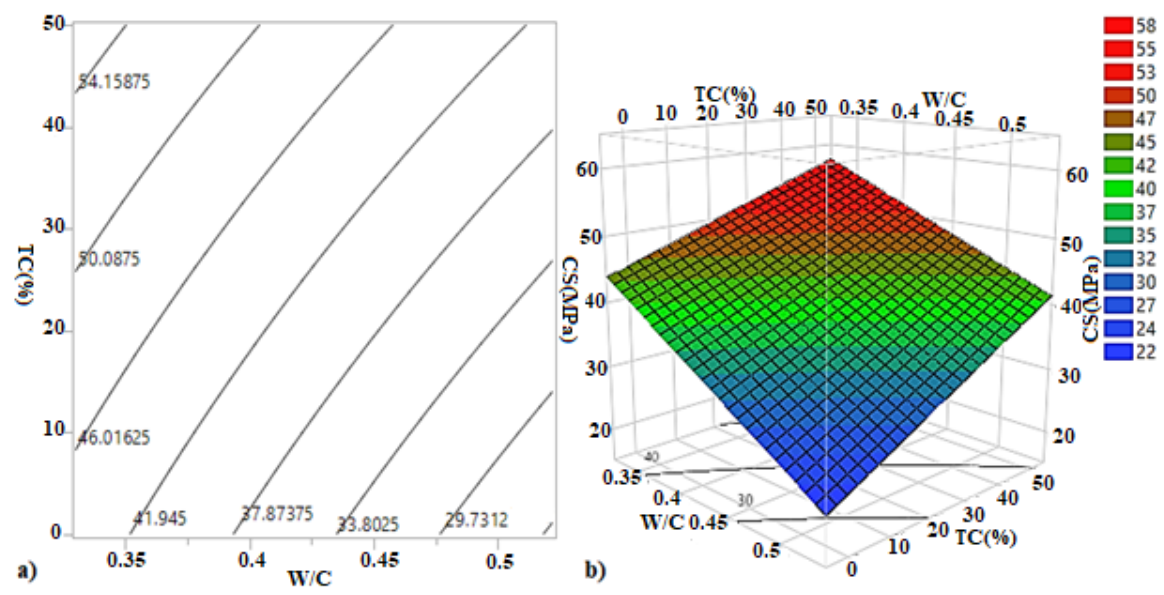
Figure 12. ( a ) Iso response curves and ( b ) response surfaces of the compressive strength of the transversal confinement.